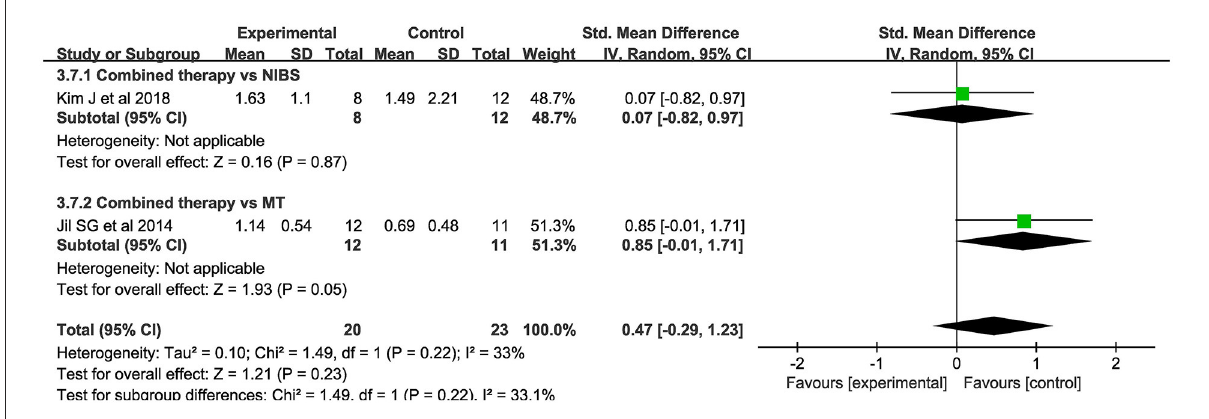
FIGURE7 Forest plot of trails comparing NIBS combined with MT vs. NIBS or MT alone for motor evoked potential [MEP] amplitude.